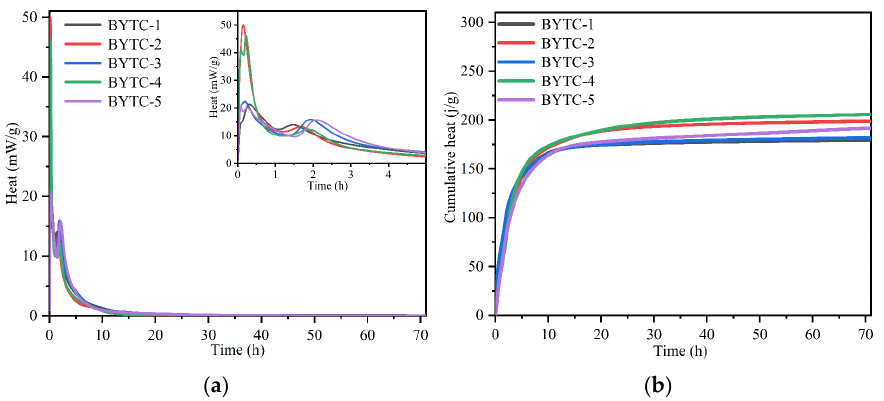
Figure 3. Isothermal calorimetry curves of per gram of cement ( a ) rate of hydration; ( b ) cumulative heat of hydration.